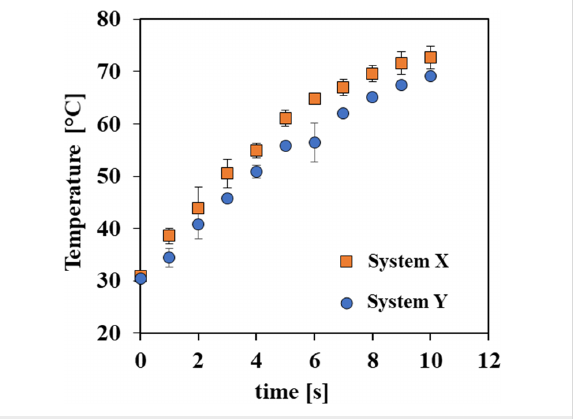
Figure 7: Top surface temperature ( T top in Figure 6c) of samples X and Y (Table 2) as a function of time. Measurements were recorded starting from T top = 30 °C.